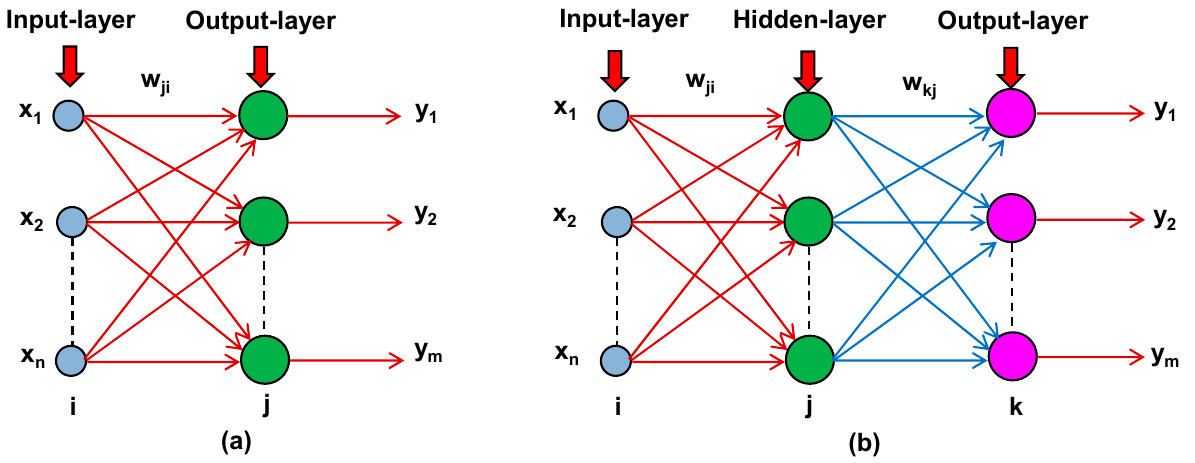
Figure 5. Schematic view of ( a ) Single-Layer Feed Forward (FF)-ANN, ( b ) Multi-Layer FF-ANN [33].